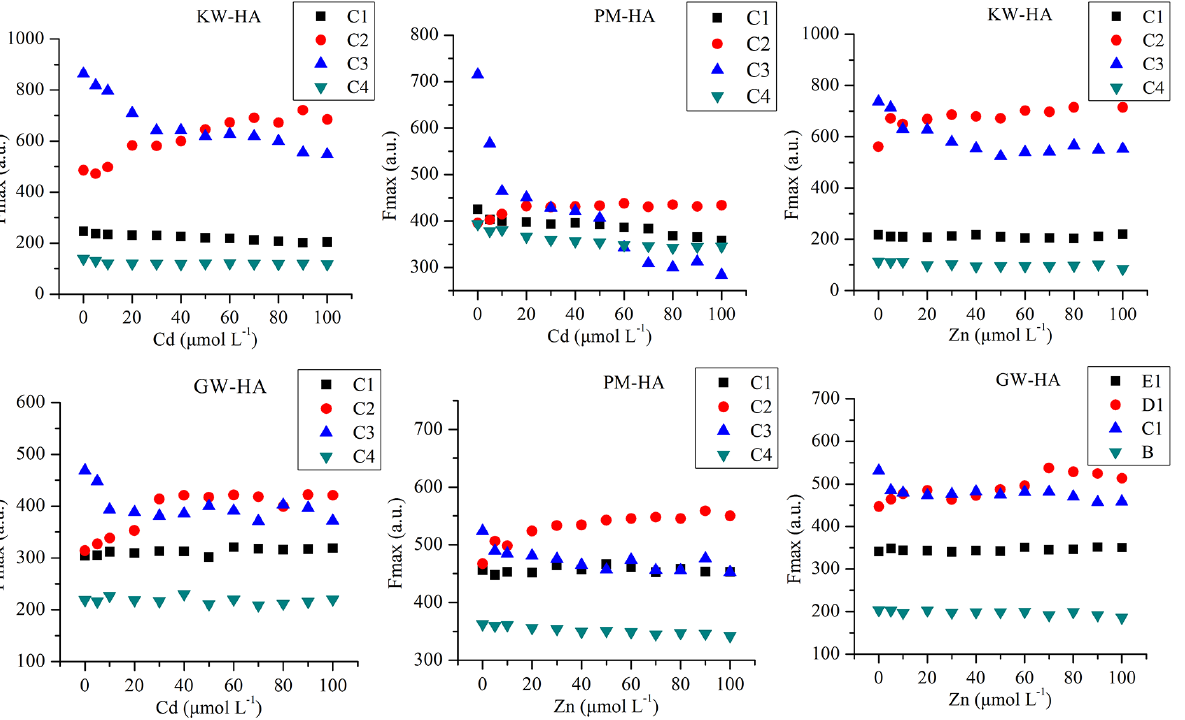
Figure 5: Changes in the Fmax values of the four PARAFAC-derived components after titrating Cd(II) and